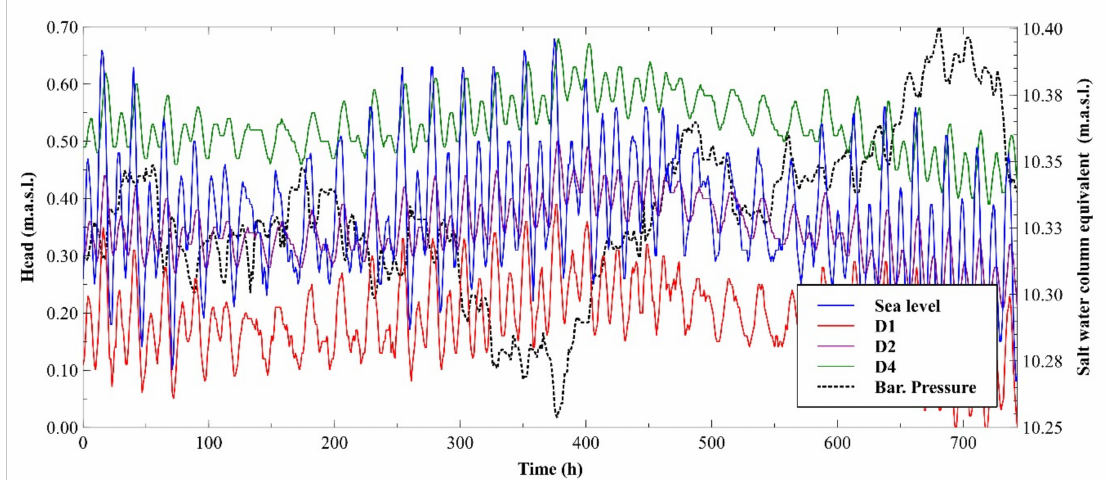
Figure 3. Sea level, piezometric head (D1, D2, and D4), and barometric pressure time series observed at the area of interest during the period of 1 August to 31 August